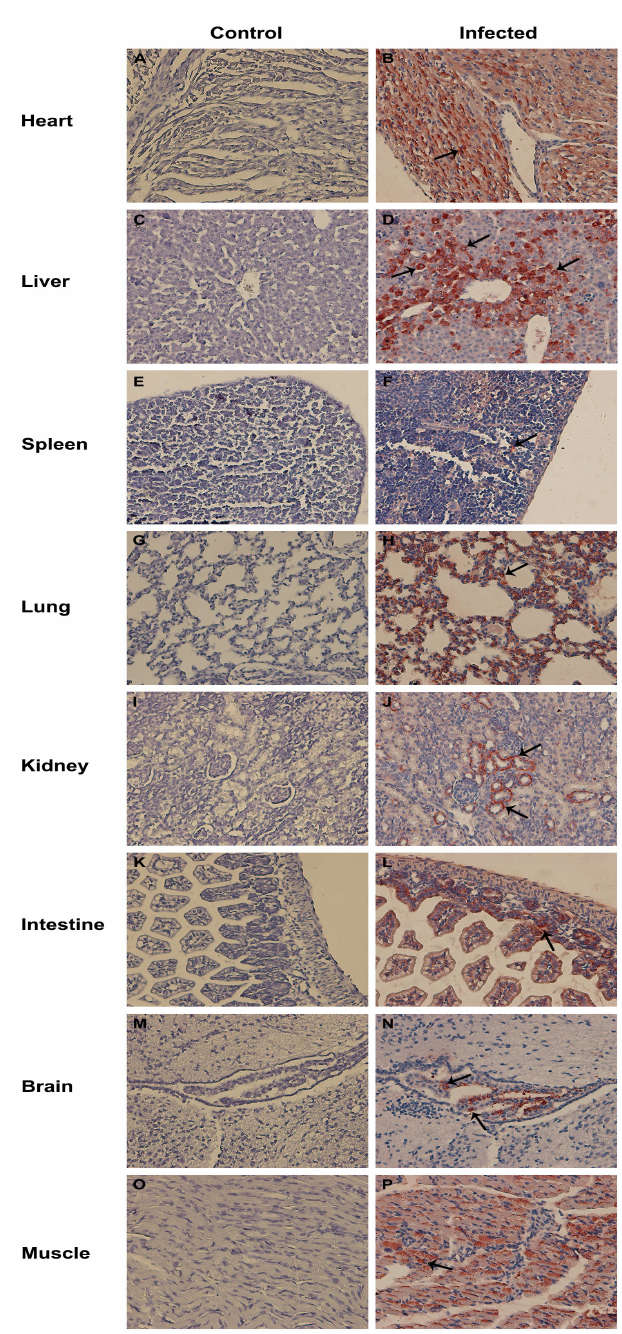
Figure 7. Representative results showing the viral tissue tropism in mice infected with CEV-JL14. Three-day-old ICR suckling mice were injected with 2 × 10 6 TCID 50 CEV-JL14 via different infective routes. Tissue samples were collected from the infected mice (5 dpi) and processed for immunohisto- chemistry assay to examine the tissue tropism of CEV-JL14. CEV-JL14 antigens were observed in the majority of the tissues examined, especially in the heart ( B ), liver ( D ), spleen ( F ), lung ( H ), kidney ( J ), intestine ( L ), brain ( N ), and muscle ( P ) as indicated by arrow in comparison with corresponding tissues in control mice ( A , C , E , G , I , K , M , O ). Heart ( B ) was obtained from mice inoculated via intra- muscular injection. Liver ( D ) and brain ( N ) were from mice inoculated via intraperitoneal injection. Tissues including spleen ( F ), kidney ( J ), and intestine ( L ) were from mice inoculated via subcutaneous injection. Lung ( H ) and muscle ( P ) were from mice inoculated via intranasal